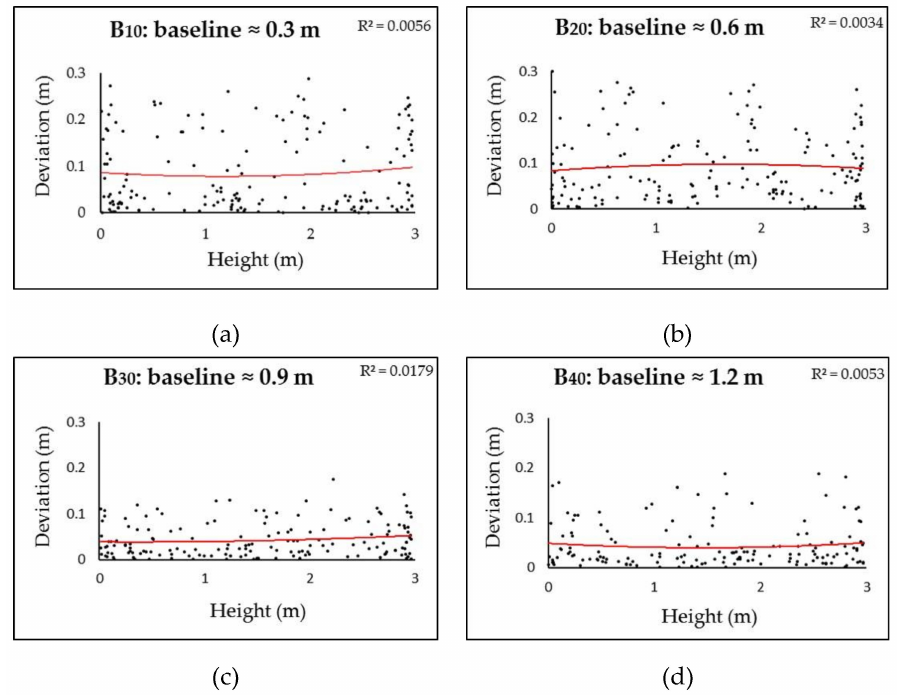
Figure 15. Correlations between height (vertical distance to the base plane) and deviations (to the GTM) in the Stupa dataset with variable baselines. Two-polynomial trend lines (in red) with correlation coefficient (R 2 ) are given.